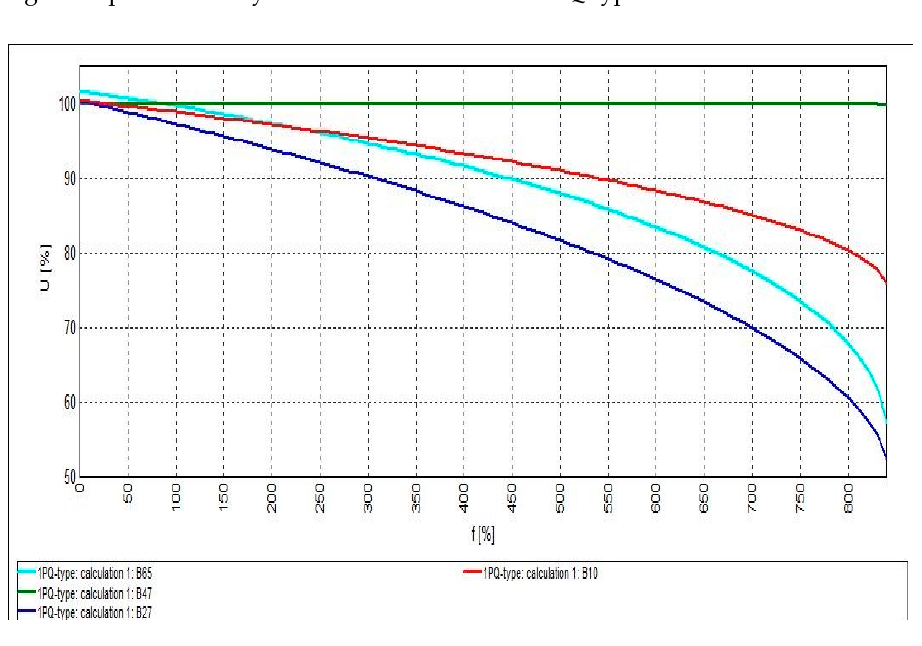
Figure 9. PV curves of the IEEE 69 ‐ node RDS system with 3 Q ‐ type DG installations.